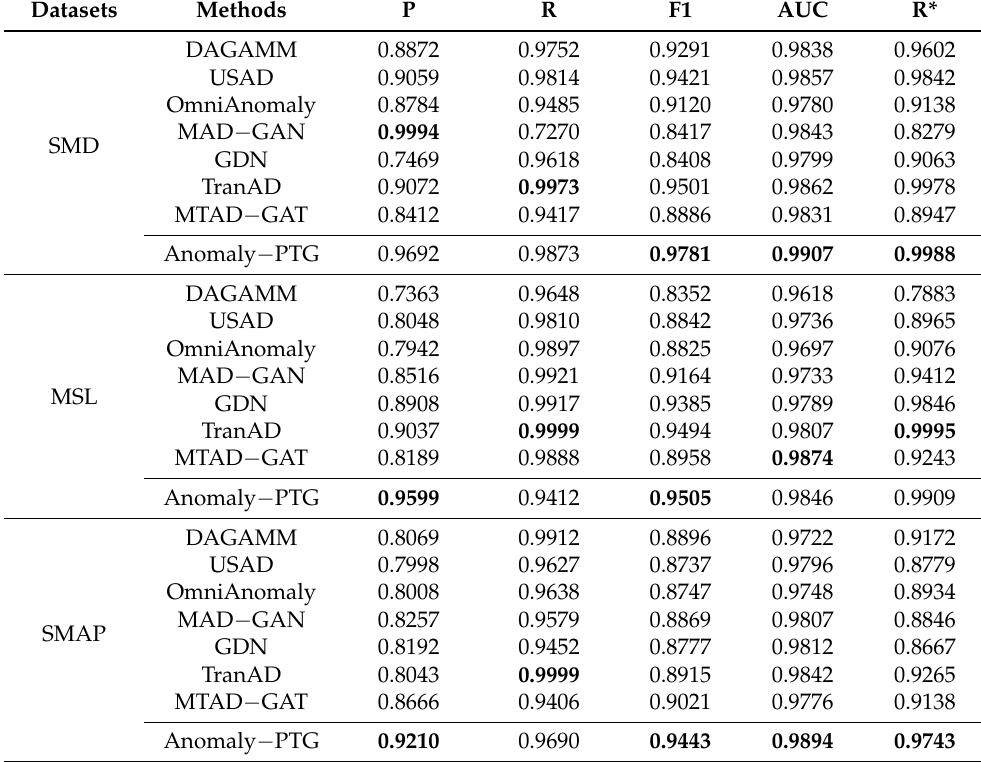
Table 3. Anomaly-PTG comparison with baseline